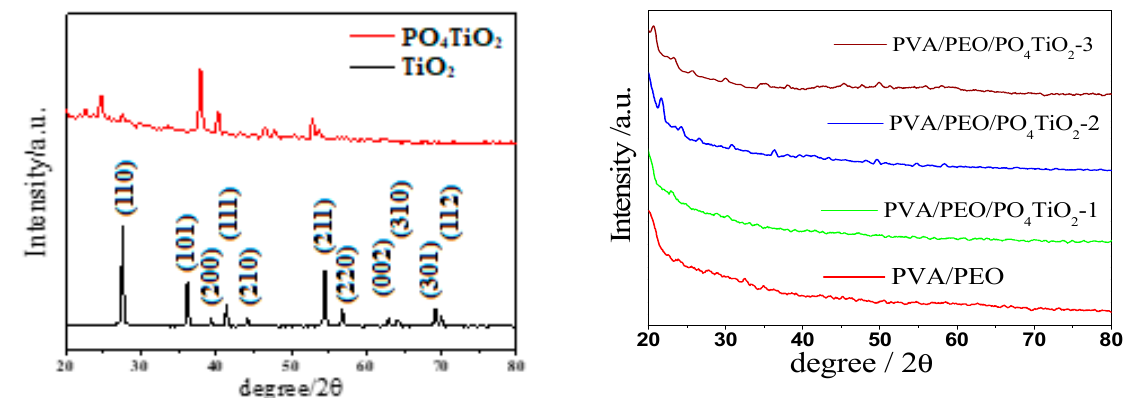
Figure 3. XRD patterns of PO 4 TiO 2 ( left chart ) and PVA/PEO/PO4TiO 2 membranes ( right chart ).